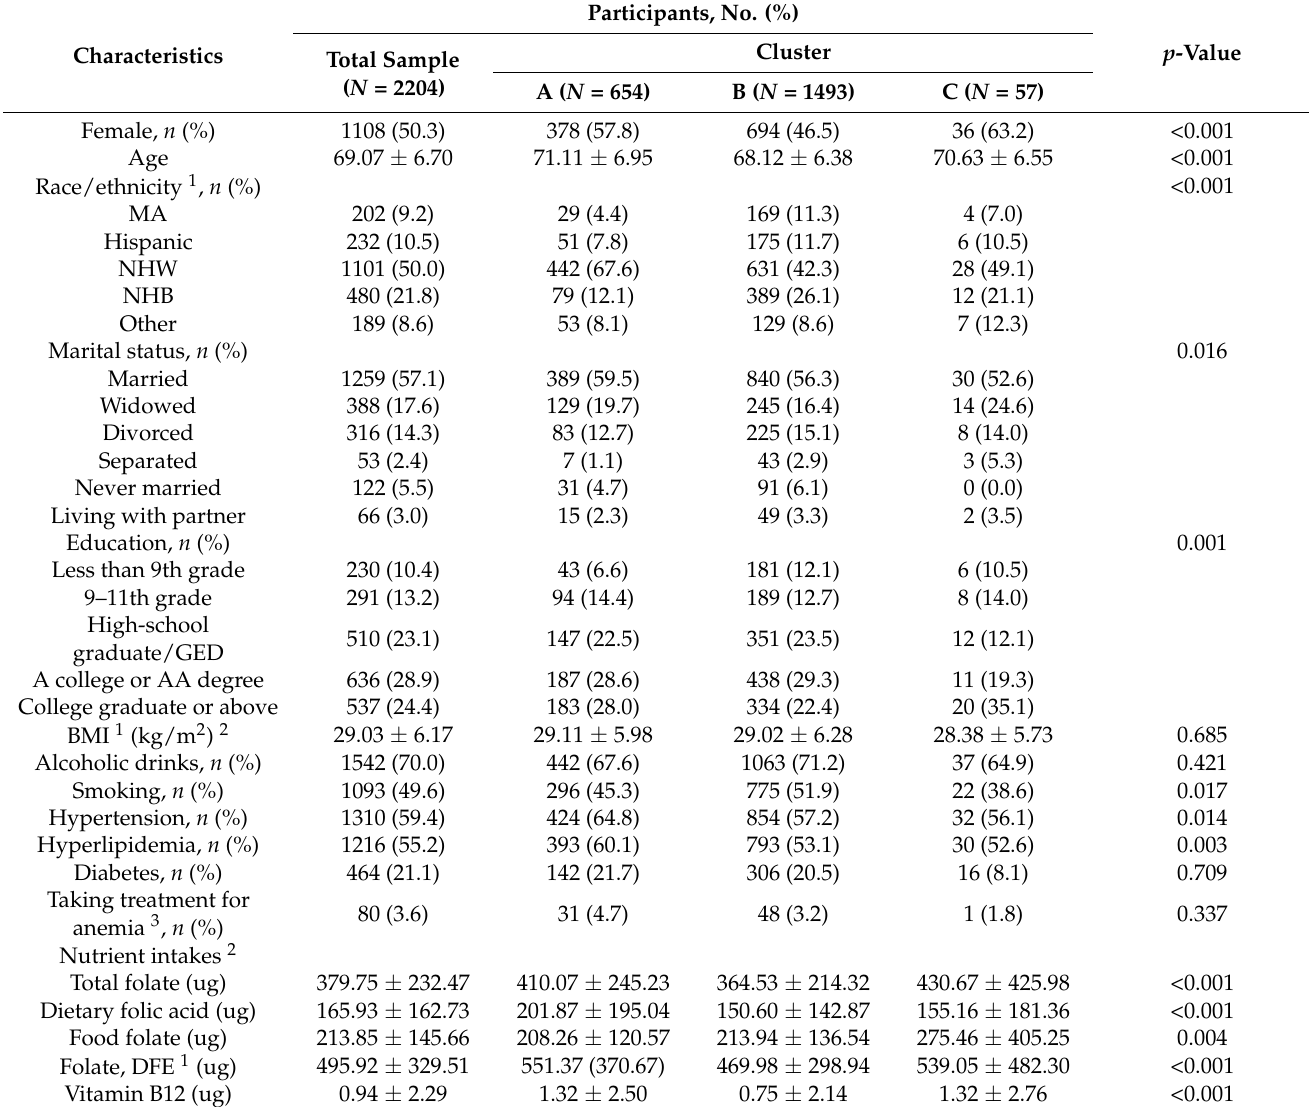
Table 3. Characteristics of clusters representing folate and vitamin B12 status of US older adults ( ≥ 60 y; n = 2204) from the 2011–2014 NHANES